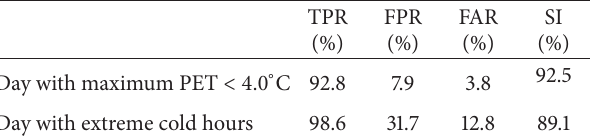
Table 6: Statistical indices for the evaluation of the forecasting ability of the developed ANN no. 2 forecasting model to predict the number of hours during the day when PET < 4.0 ∘ C (extreme cold stress). One day ahead prognosis. Cold period of